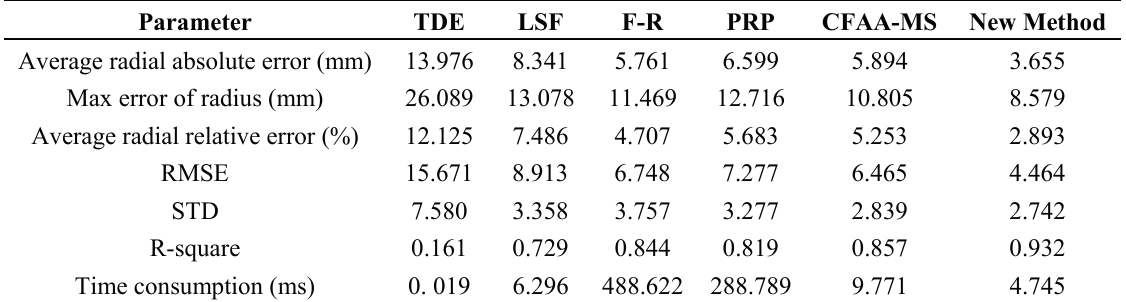
Table 3. Experimental result of new algorithm compared with related